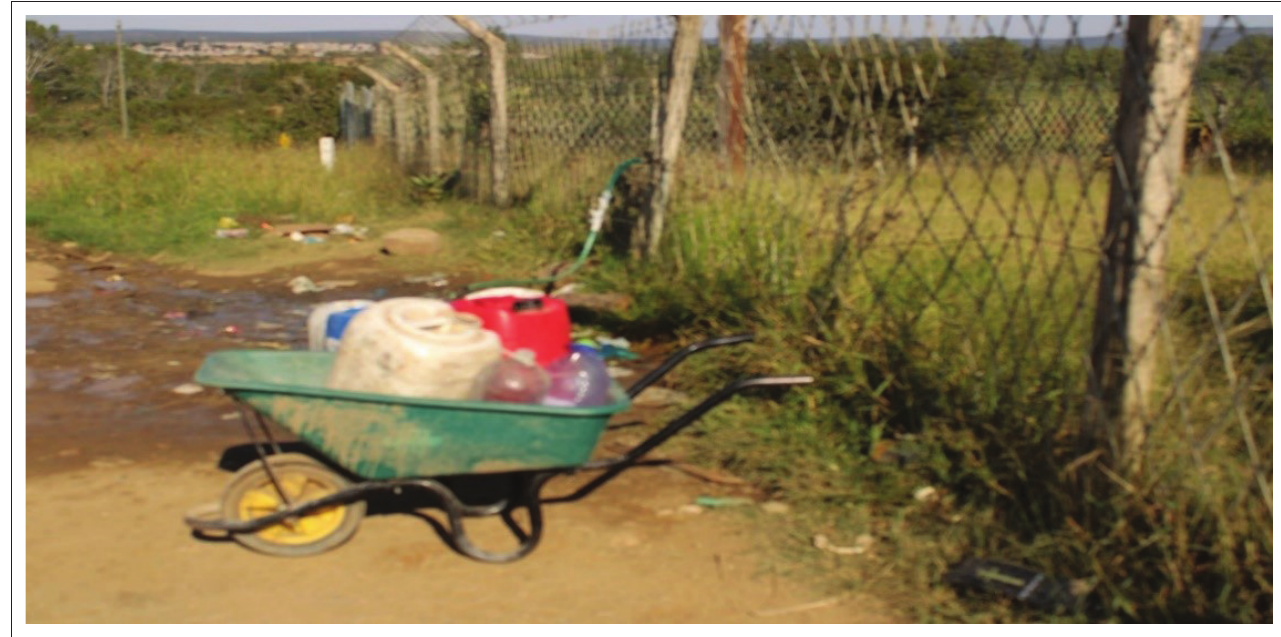
FIGURE 2: Rural community member poaching from one of the water treatments